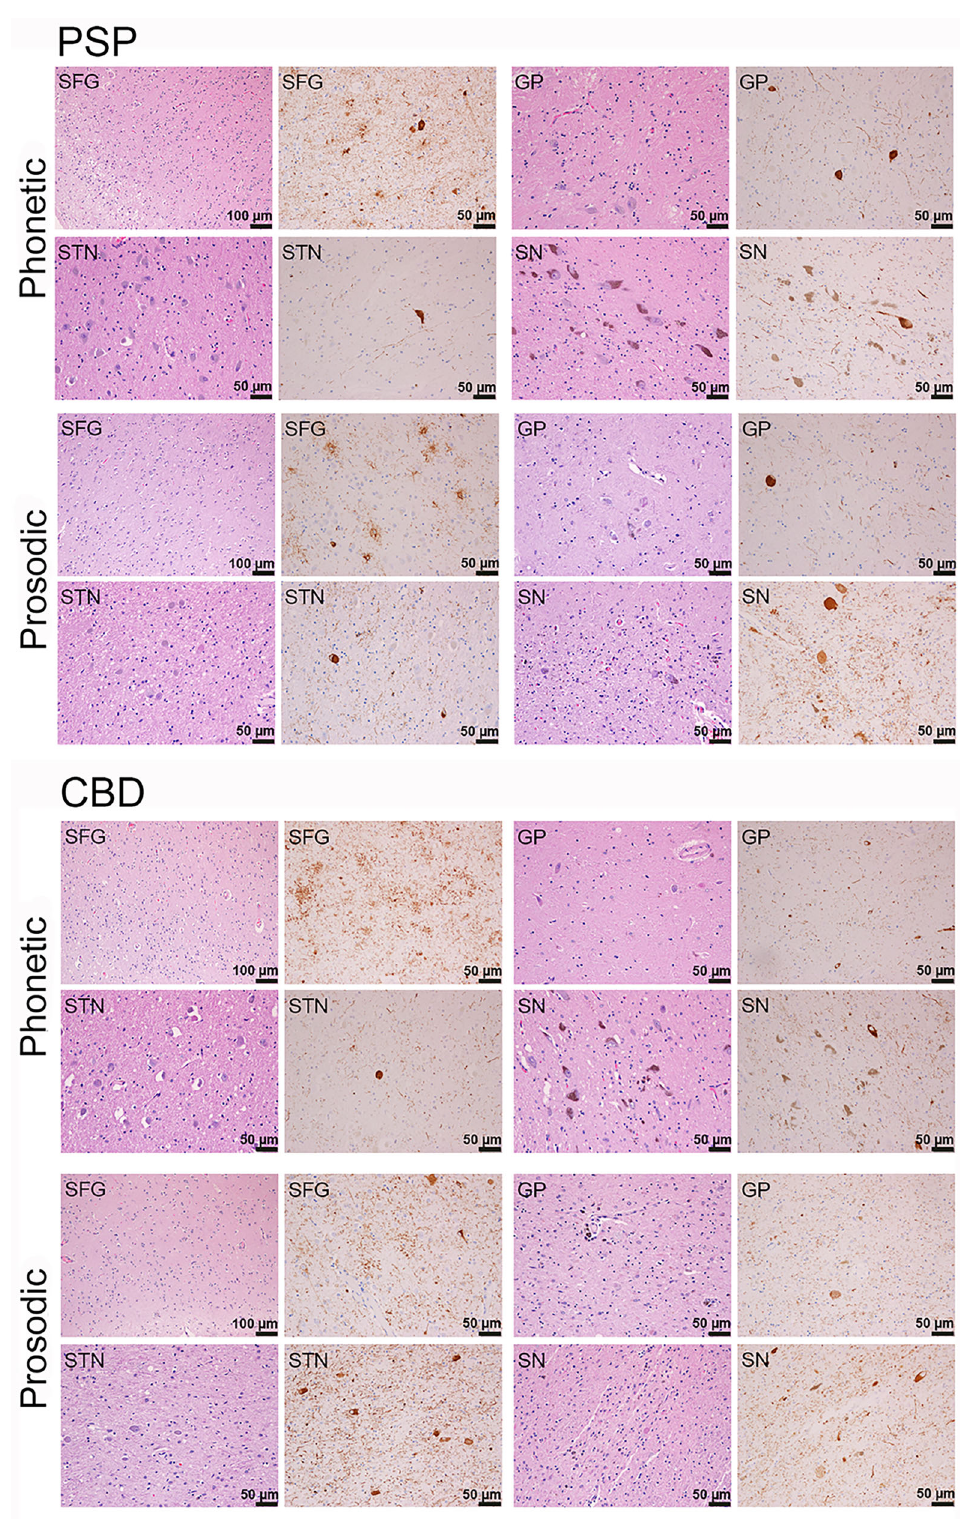
temporoparietal and frontal cortices (Supplementary Fig. 8). Of the two PiD cases, one did not have the expected lobar (knife edge) atrophy (Supplementary Fig. 1). However, both showed frontal hypometabolism (Supplementary Fig. 8). The fi fth patient had dysarthria, facial and limb weakness, and mixed pathologies including AGD and co-existing TDP-43 without loss of Betz cells